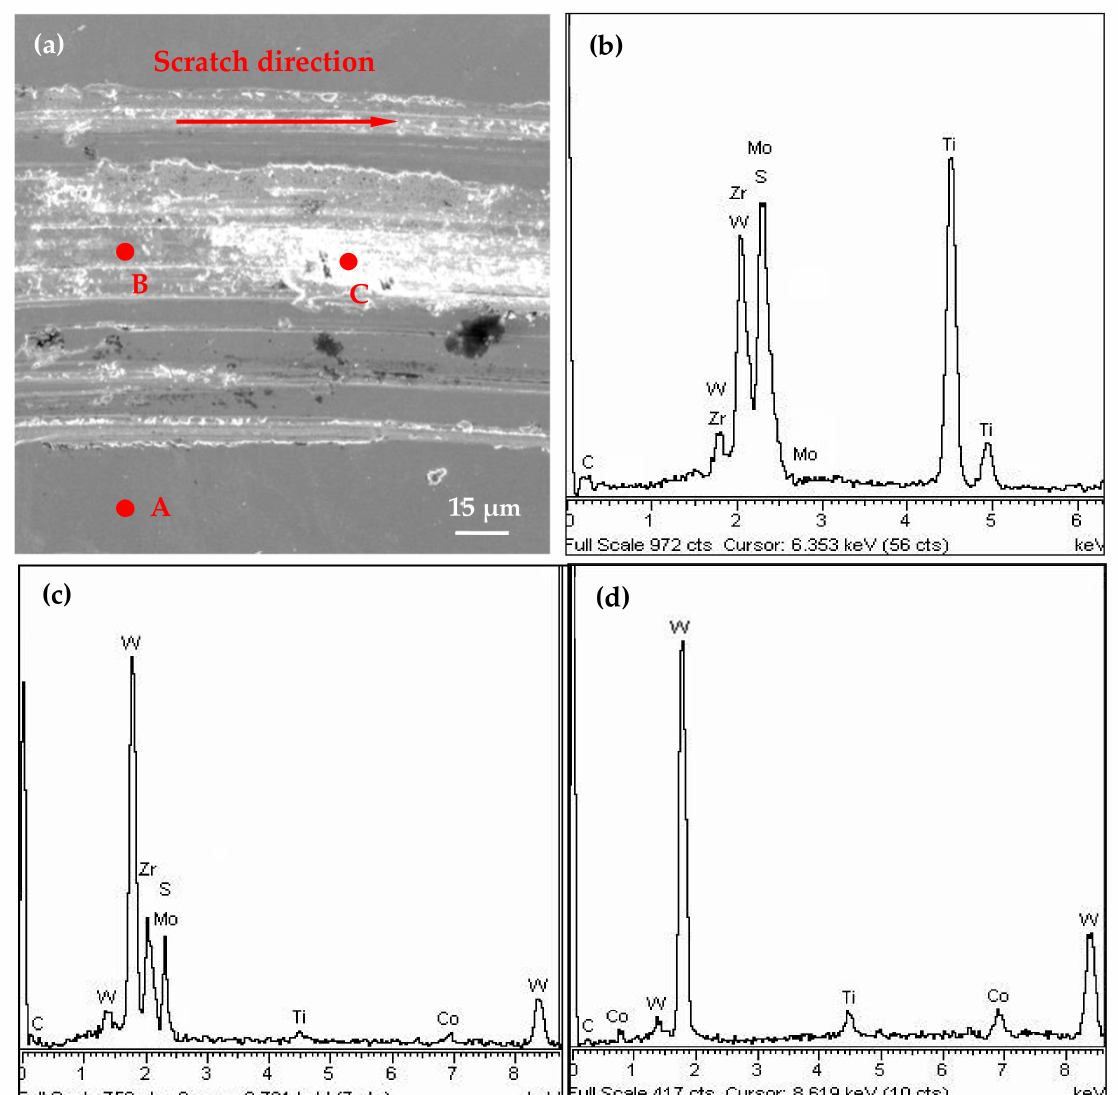
Figure 5. Scratch micrographs ( a ) at the scratch force of 70 N for the T180 sample and corresponding EDX analyses ( b – d ) of points A–C in Figure